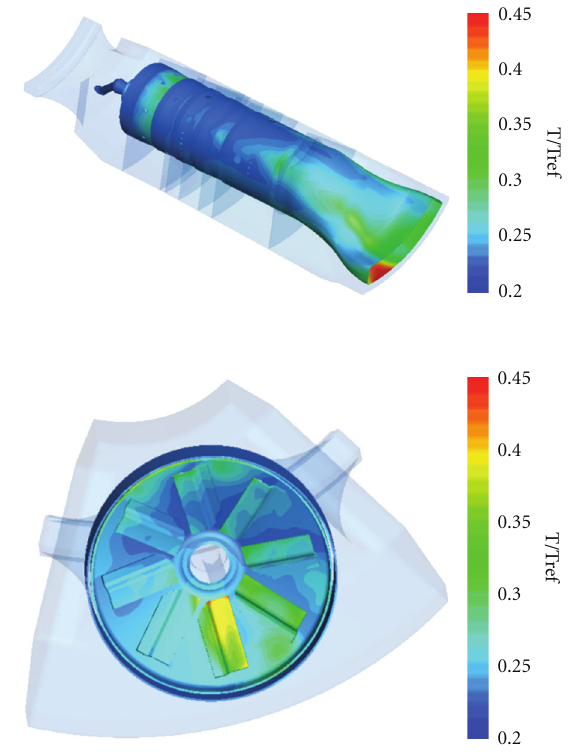
Figure 12: Combustor can and dome temperature contours at